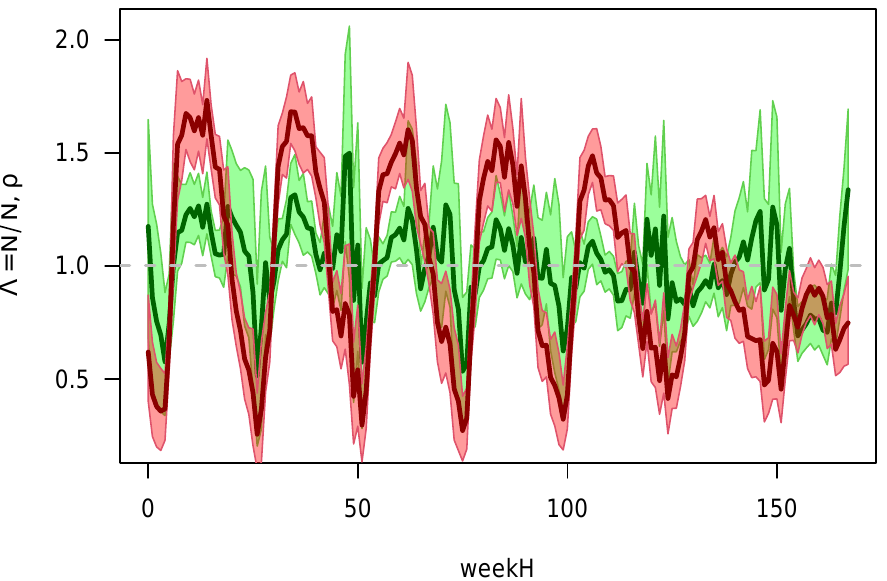
Figure 16. The prediction index Λ (green) as a function of the hour of the week, together with the safety index ˆ ρ (red). The shaded areas are the 99% confidence intervals of the mean values which have been computed by